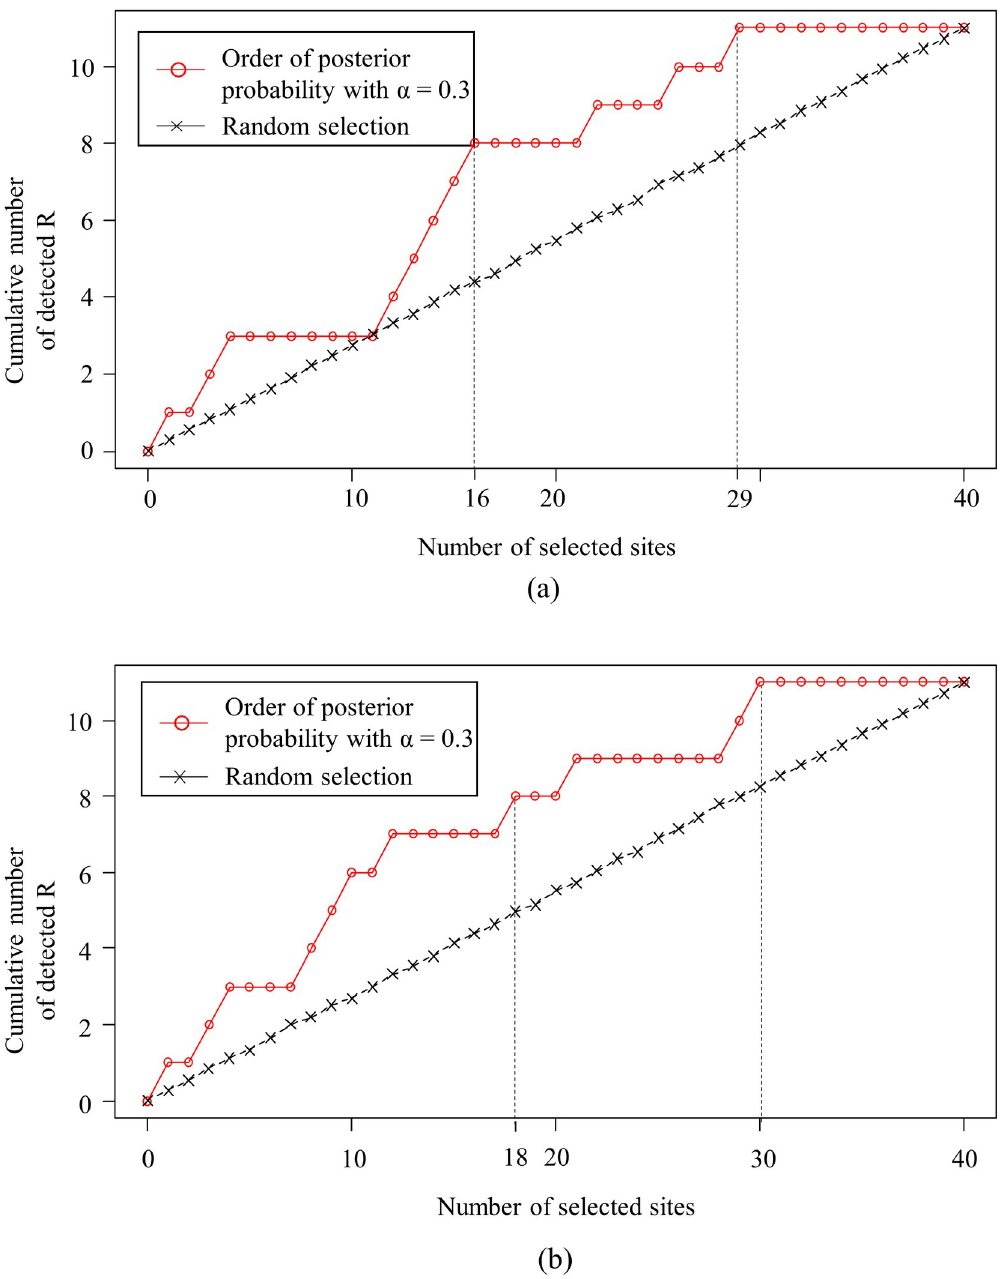
Fig 6. Performance in detecting reproducible fatal collision sites on six routes with α = 0.3: (a) CRP A as a prior probability and (b) CRP FI as a prior